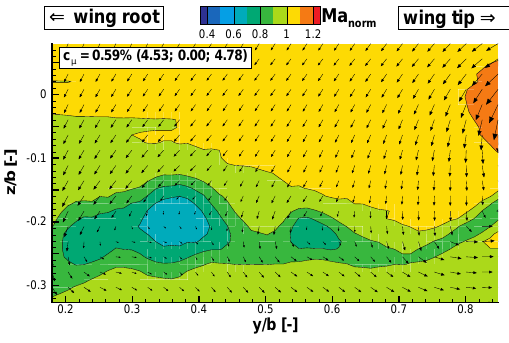
Figure 24. Wake flow at ( α max , base + 2.3 ◦ ) for the controlled